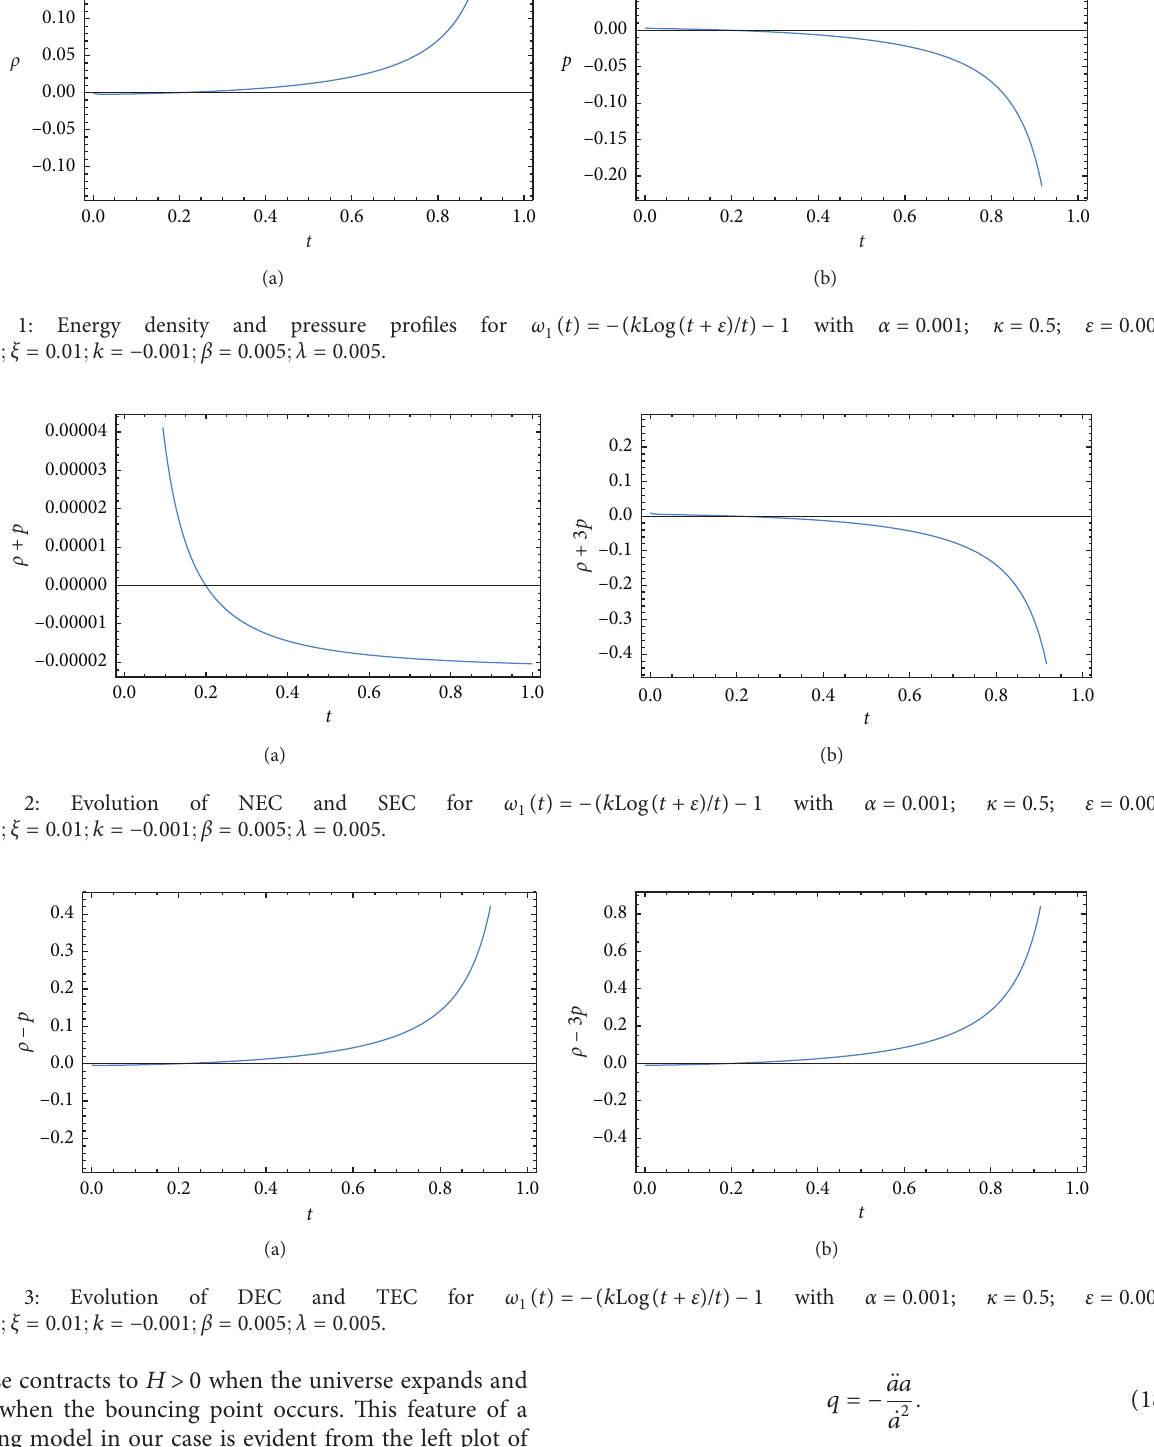
The negative trend of the deceleration parameter is shown in the right plot of Figure 5. The behavior of the EoS